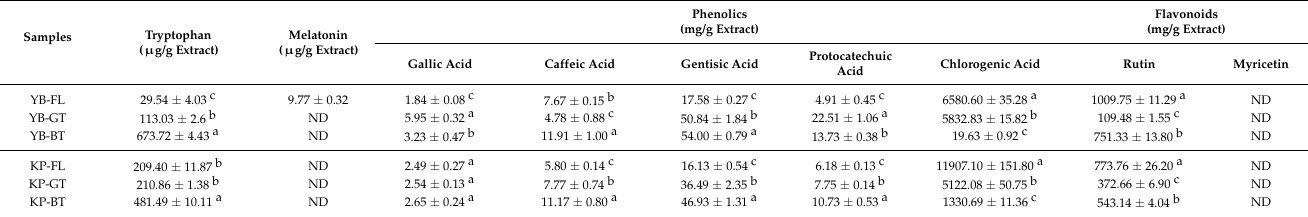
Table 2. Quantification of phenolic and flavonoid compounds from mulberry leaf extracts by LC- MS